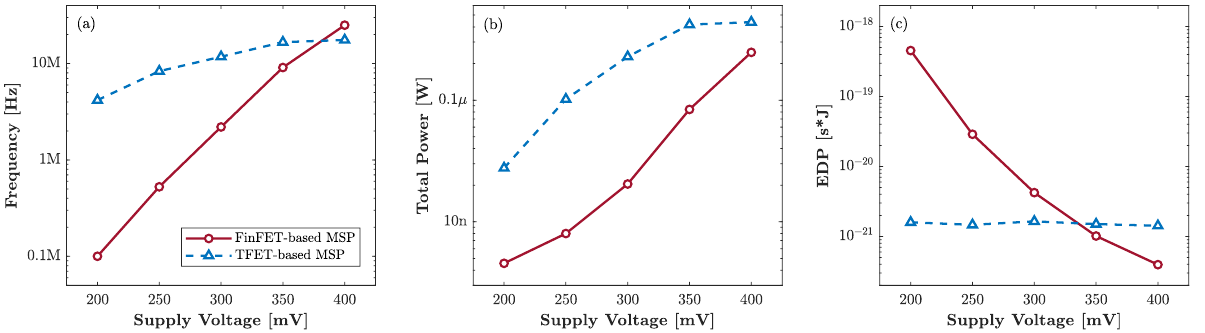
Figure 9. ( a ) Maximum frequency of operation, ( b ) total power consumption, and ( c ) EDP of a TFET- and FinFET-based MSP-430 across a supply voltage range of 200 mV to 400